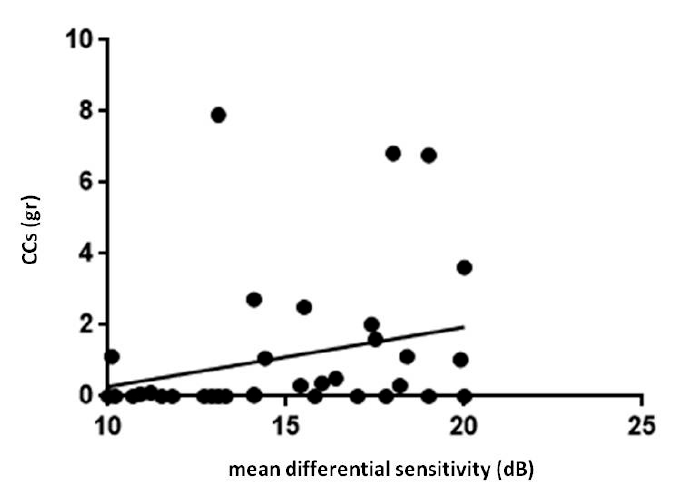
Figure 4. Retinal light sensitivity and glucocorticoids in patients with psoriatic arthritis sine psoriasis. FP, Fundus Perimetry; CCs, corticosteroids. In patients with psoriatic arthritis, FP mean differential sensitivity showed a positive correlation with cumulative dose of CCs (r = 0.4, p = 0.02). Statistical analysis was performed by Spearman correlation. P values < 0.05 were considered significant (* p < 0.05).